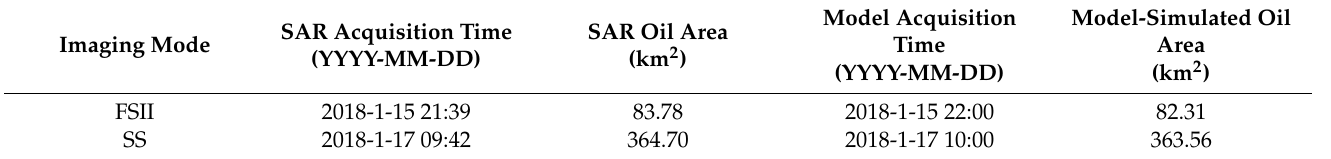
Figure 9. ( a ) The GF-3 SAR image on 17 January 2018 at 09:01, in which the pinkish marks represent the shipwreck position, and sub-scenes b through g are used to extract spilled oil slicks; and ( b ) to ( g ) The results of extracted oil-slicks from sub-scenes b to g, which are marked by black spots. Table 1. The comparison of spatial coverage between SAR-detected and model-simulated oil slicks.